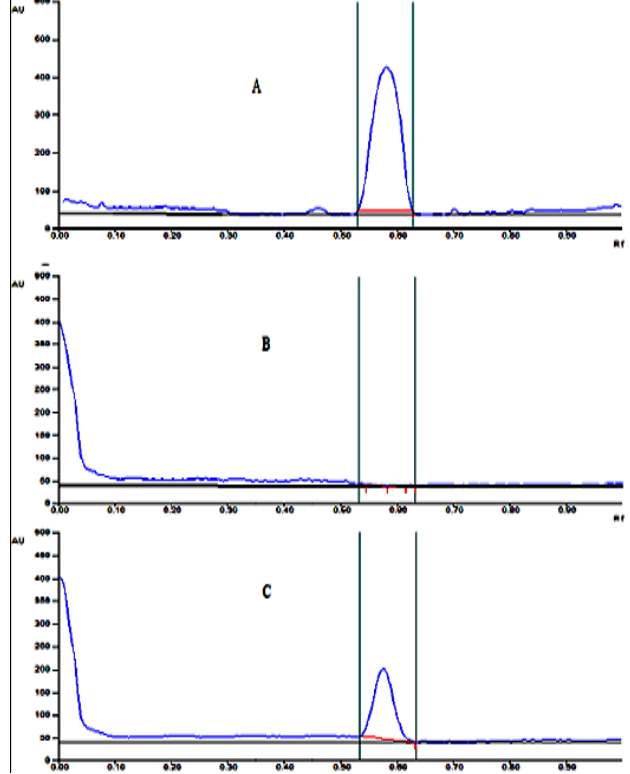
Figure 2. TLC densitometric chromatogram for specificity test. (A) Sibutramine HCl standard, (B) blank sample (free of sibutramine HCl), and (C) sample spiked with sibutramine